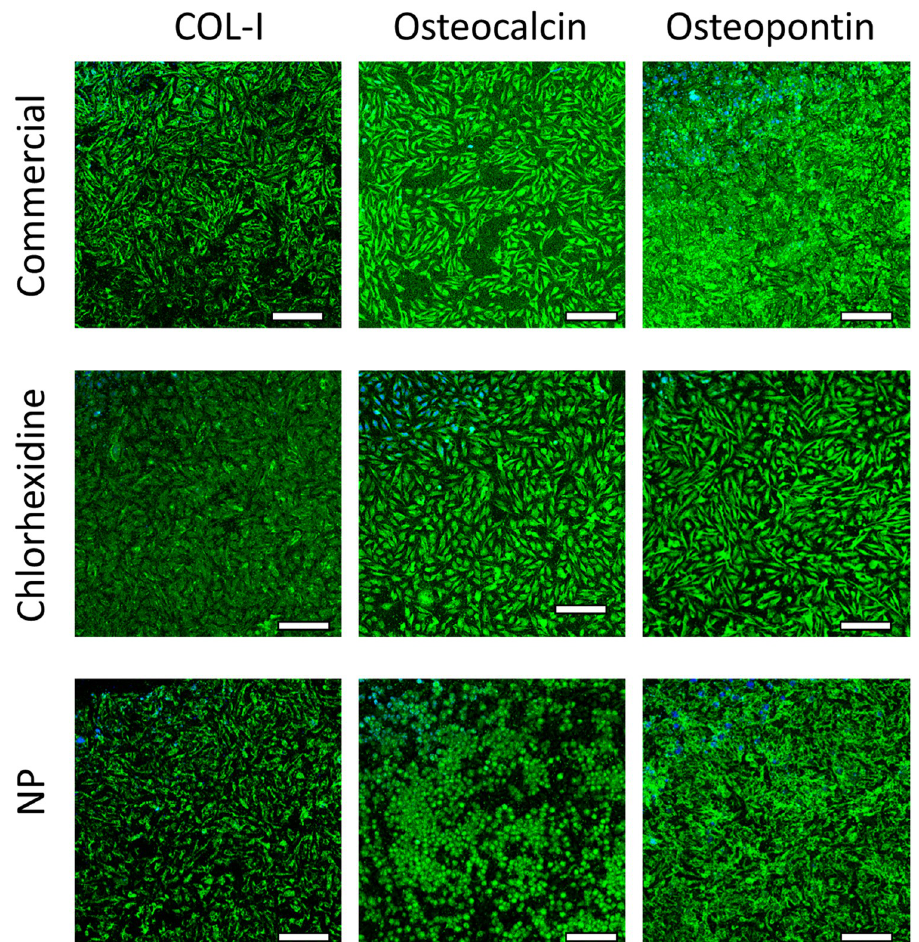
Fig 9. Histological testing of bone cement. Examples of fluorescence microscope images of collagen type1, osteopontin and osteocalcin in SaoS-2 cells after exposure to release media from Cemex 1 bone cement (a), Cemex 1 containing chlorhexidine powder 3% w/w (b) and coated silica nanoparticles (c) (bar represents 100 μ m).